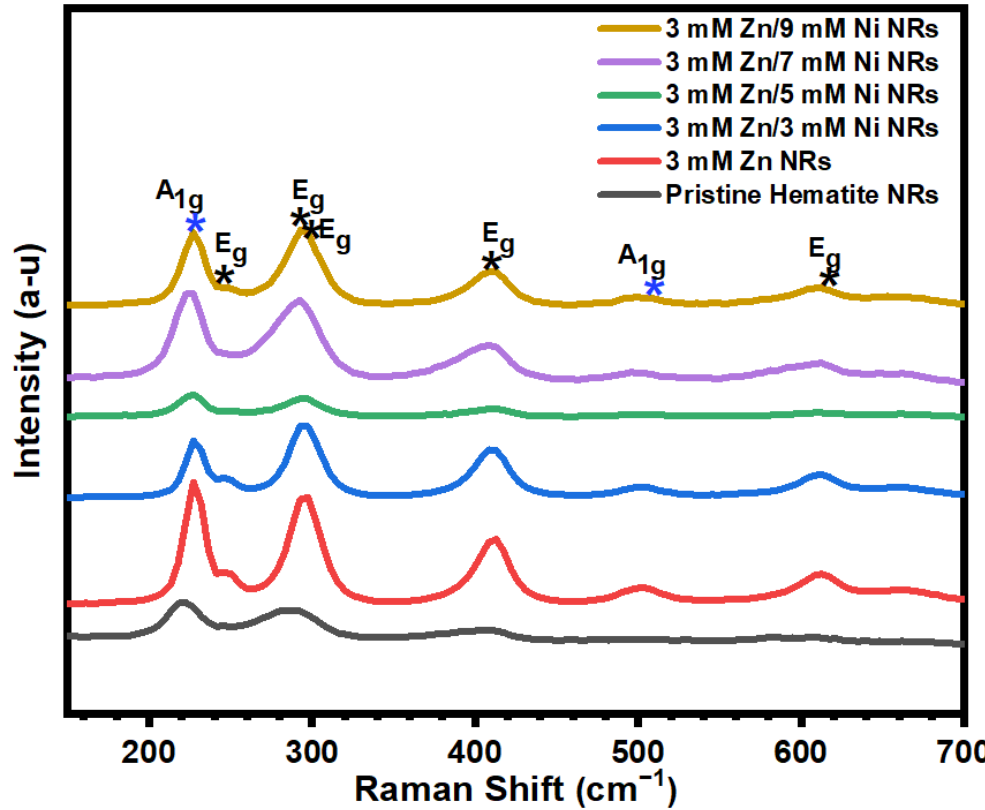
Figure 6. Raman spectra of pristine and doped hematite NRs grown over hematite seed layers.